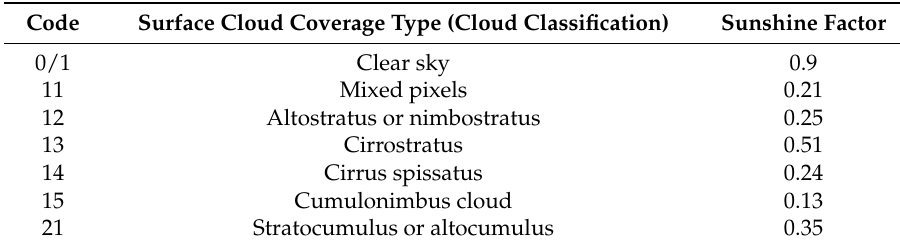
Table 4. FY-2D cloud type sunshine factor over the Heihe River